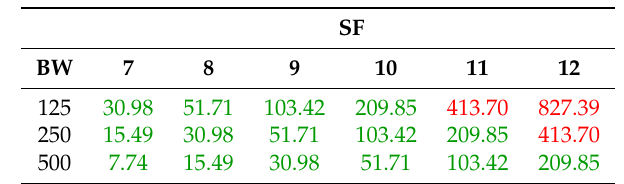
Table 14. Values of T packet in ms depending on BW and SF, with CR = 1, CRC disabled, and implicit header. The red color indicates values of the table that are not feasible. The green color indicates values of the table that are